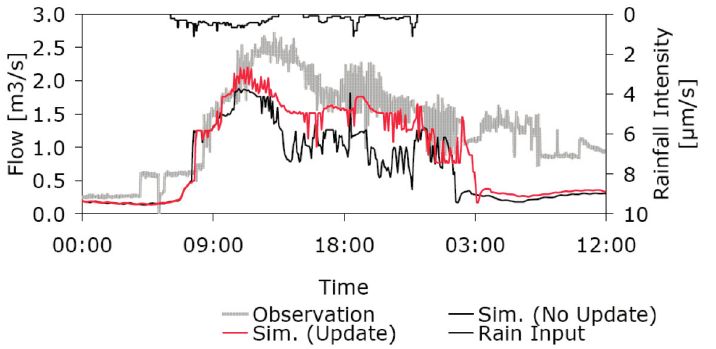
Figure 7. Rainfall (from the top, black curve) and observed flow (grey curve) at the outlet in Kolding on 25 and 26 December 2009, along with the simulated flow with (red curve, Update) and without (black curve, No Update) updating in the upstream nodes.